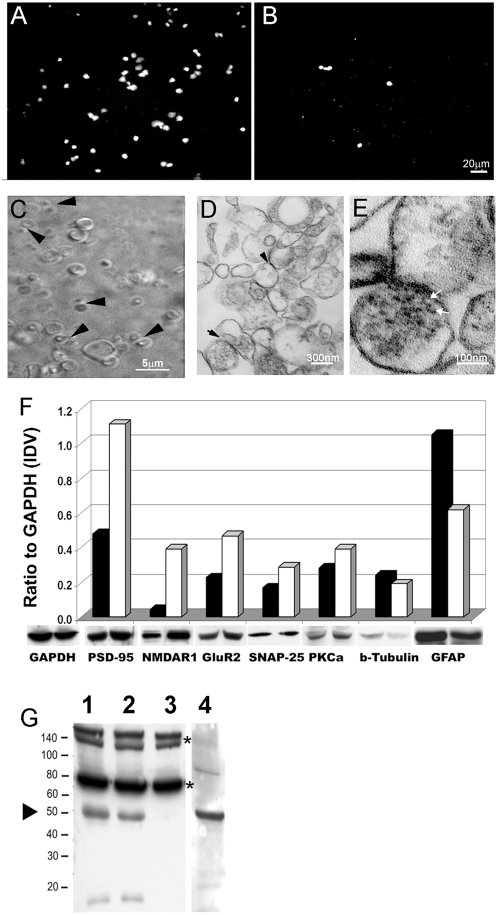
Enrichment and stability of synaptoneurosomes.Microscopy: A) Nuclear contamination of the homogenate (2 µl smears) (DAPI fluorescence) decreases after sequential passage through mesh screens with B) the post- 10 µm screen synaptoneurosome pellet (100 µl volume) still retaining a few nuclei (Bar = 20 µm). C) Intact synaptoneurosomes are detected by phase contrast in smears of pelleted post-10 µm screen synaptoneurosome as typical “snowman” pre- and postsynaptic profiles (arrowheads). Larger, empty, membranous structures are also observed. (Bar = 5 µm). D) Electron microscopy reveal “snowman” profiles with apparent postsynaptic densities (arrowheads); (Bar = 300 nm). E) At higher magnification, presynaptic terminals containing synaptic vesicles, 20 nm in size (white arrows) are indicated (Bar = 100 nm). Immunoblots: F) Homogenates (black bars) and synaptoneurosomes (white bars) were compared for stability and enrichment of synaptic proteins and contamination with other cellular debris. Densitometric comparison on immunoblots of postsynaptic proteins PSD-95, NMDAR1 and GluR2 in synaptoneurosomes shows more than a two-fold enrichment compared to homogenates, an increase in presynaptic protein SNAP-25 but a 40% decrease in glial protein GFAP. Cytoplasmic proteins β-tubulin and PKCα show little change. The ratio of each protein to GAPDH is given in arbitrary units based on the integrated density value which is the sum of all pixel values after background correction (IDV). G) In synaptoneurosomes, de novo synthesis of several proteins is observed as newly translated, biotinylated proteins detected with streptavidin (lane 1), and one at 50 kD co-migrates with a band detected with antibody to αCAMKII (lane 4,arrowhead). Actinomycin D, a transcription inhibitor, does not reduce the protein band profile (lane 2). Protein synthesis is inhibited by the translation inhibitor, anisomycin (lane 3), although endogenously biotinylated proteins present in synaptoneurosomes are still seen at ∼140 and 75 kD (asterisks).